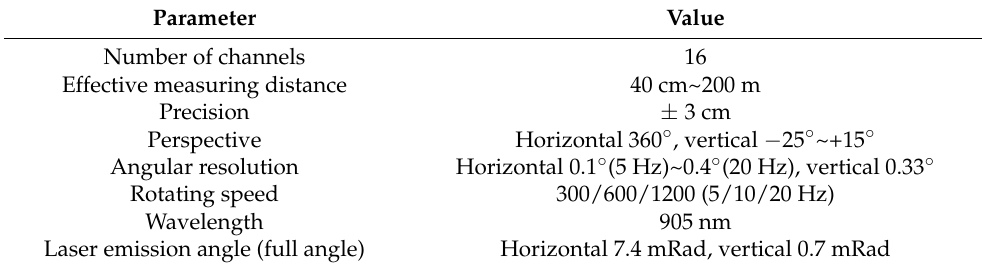
Figure 8. Autonomous mobile robot and the layout of each sensor, the frame of each sensor reference system is represented as a red-green-blue axes. Table 1. The main parameters of RS-LIDAR-16 LIDAR.